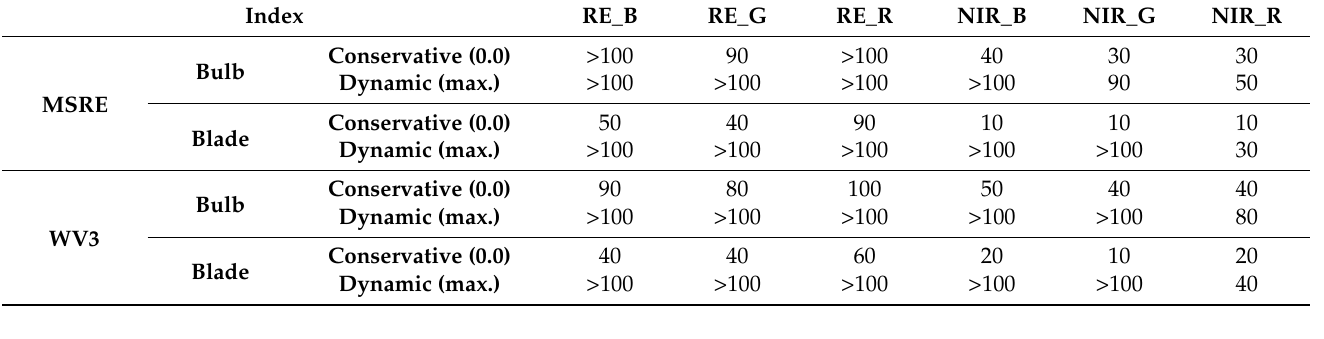
Table 5. Depth detection limits (cm) based on conservative threshold of 0.0 and the dynamic thresh- olds (maximum water value) for Nereocystis bulbs and blades, as simulated to Micasense RedEdge- MX (MSRE) and WorldView-3 (WV3) bandwidths.